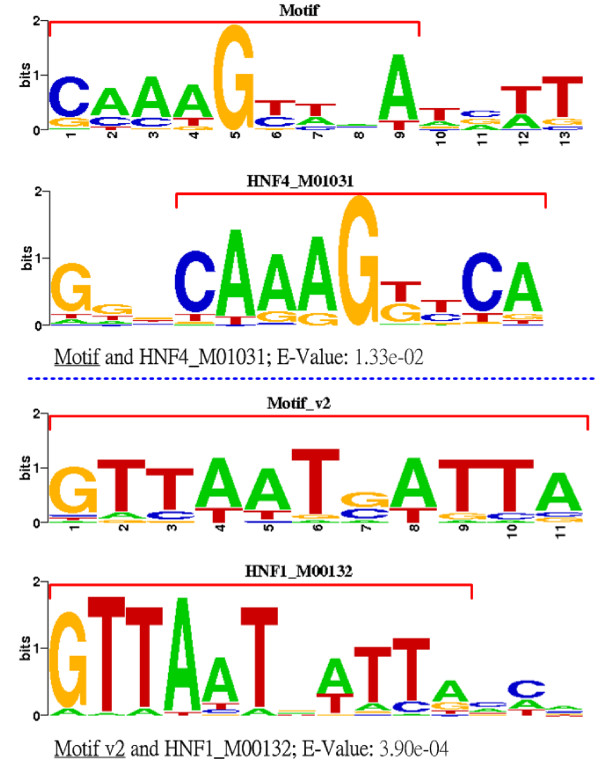
TFBS matches of the liver dataset. The matches from TRANSFAC for the top 2 high-scored motifs. The red brackets indicate the aligned blocks.